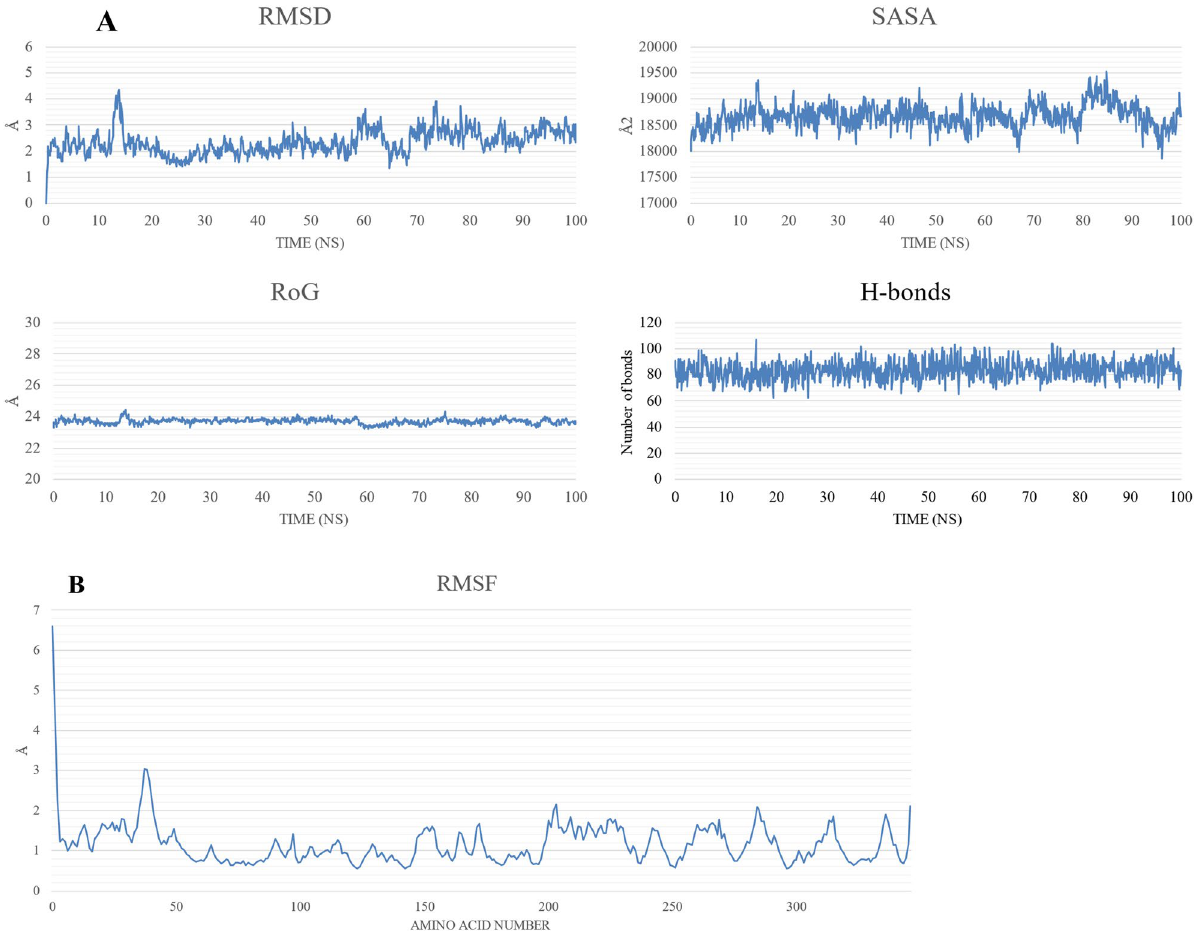
Figure 4. The molecular dynamics simulation analysis of the NSP15-ZINC000104379474 complex. ( A ) The radius of gyration (RoG) in Å, root-mean-square displacement (RMSD) in Å, surface accessible surface area (SASA) in Å 2 , and the total number of H-bonds versus the simulation time in ns. ( B ) The per-residue root-men- square fluctuation (RMSF) in